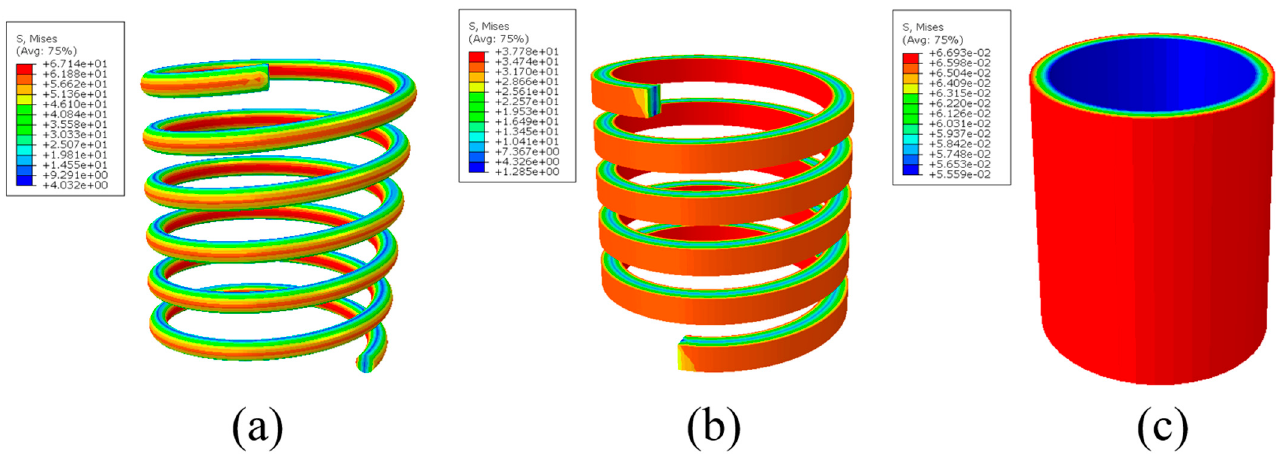
Figure 4. The Von Mises stress distributions of ( a ) the spring of the circular cross-section, ( b ) the SMAMS and ( c ) the tube under the torque of 0.1 N·m.